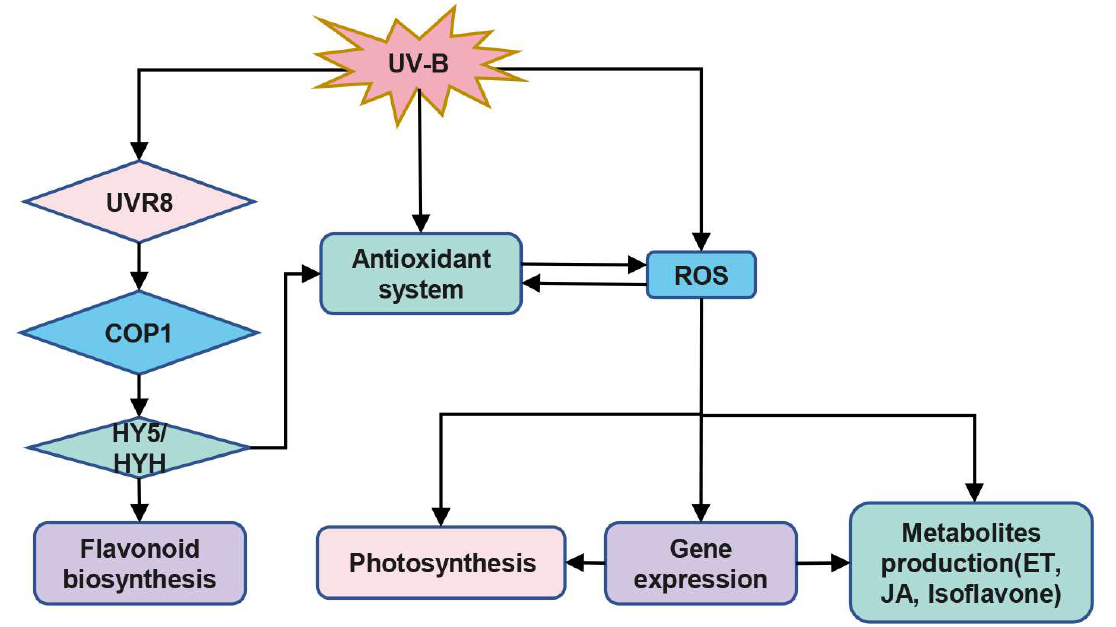
Figure 1. A simple mechanism for plant response to UV-B. ROS, reactive oxygen species; UVR8/COP1, regulators of UV-B responses; HY5/HYH, transcription factors; ET, ethylene; JA, jasmonic acid.